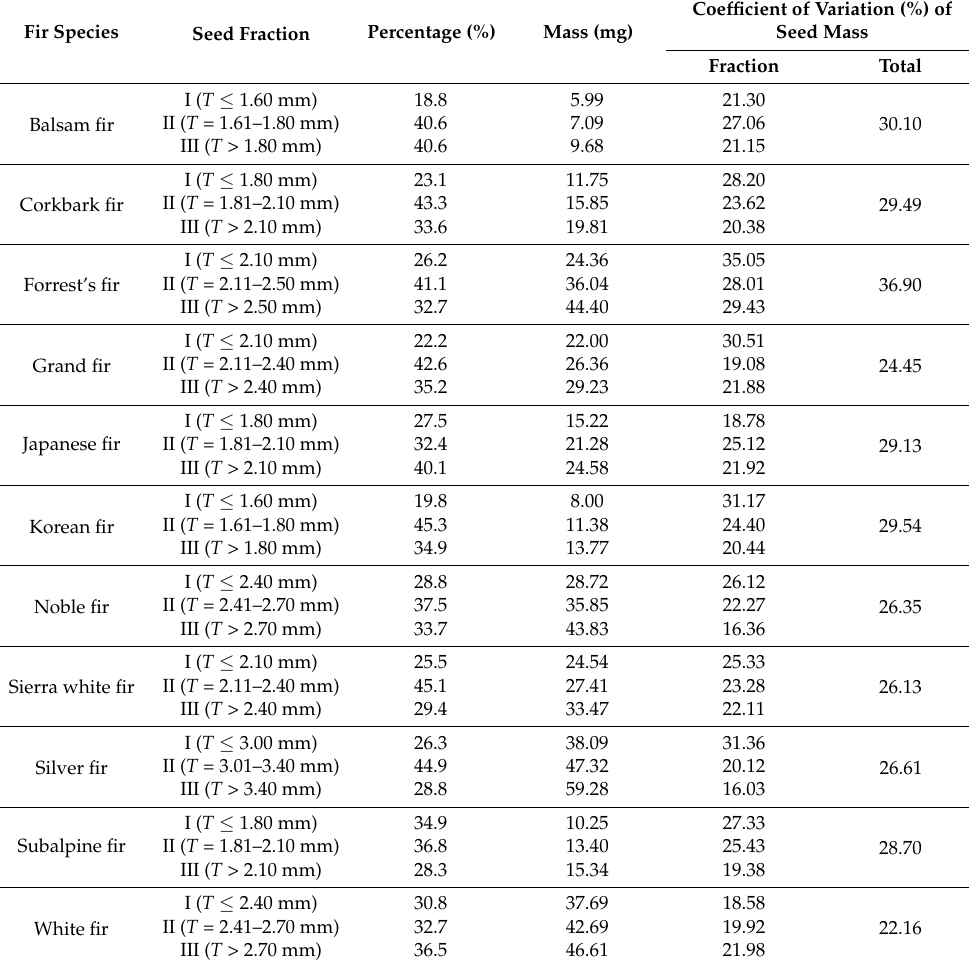
Table 6. Coefficient of variation of seed mass in three seed fractions separated based on thickness. Fir